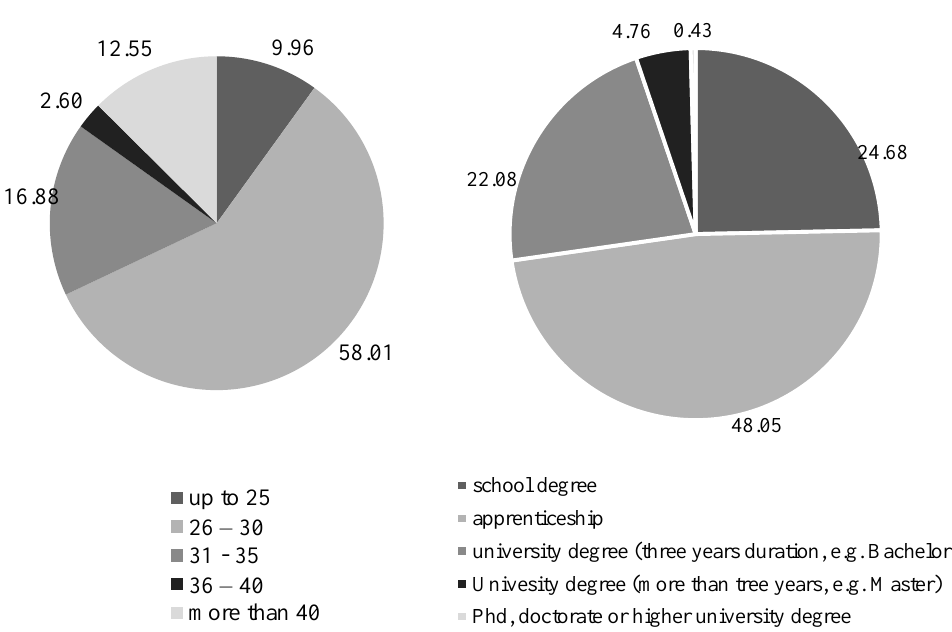
Fig. 1. Distribution of respondents by education and age, n = 231 (Survey performed by Tom Sander,